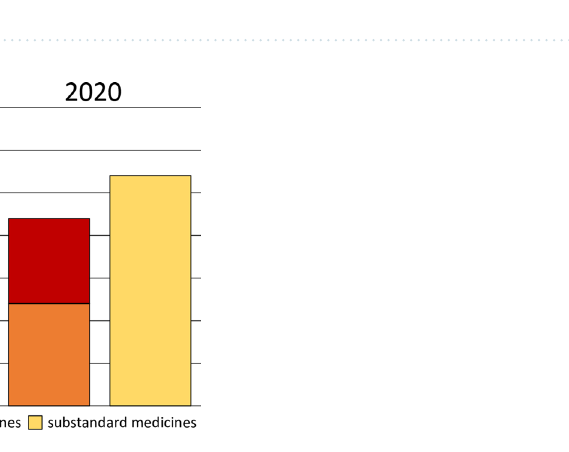
Figure 3. Examples of TLC analysis of samples of the present study, showing ( a ) decomposition of the API; ( b ) absence of the declared APIs; ( c ) API content 12.2% of the stated amount; ( d ) absence of the declared API, and presence of a non-declared API (the non-declared API glibenclamide is not visible in the depicted TLC plate, but was discovered by the local partner in an additional, specific TLC analysis for glibenclamide, prompted by the observed hypoglycemic effect of the falsified medication 36 ). (Photos: Gesa Gnegel, Lutz Heide and Difäm- EPN Minilab Network).